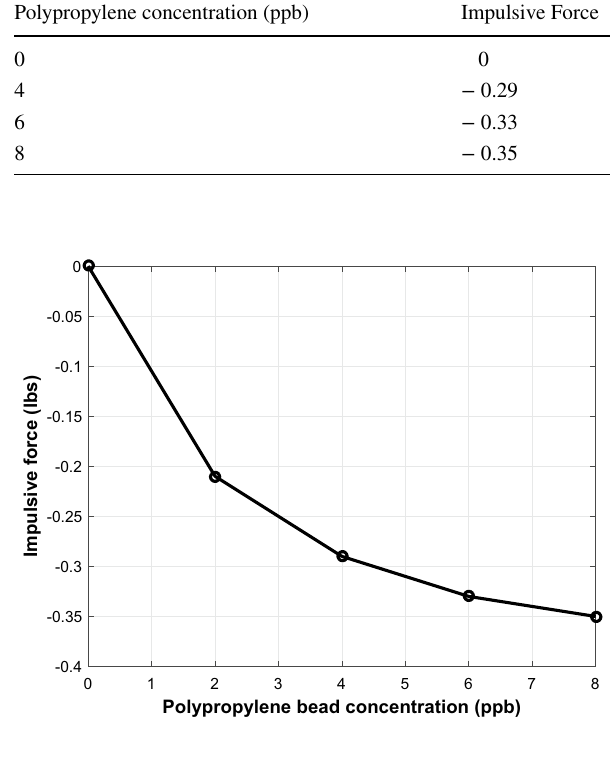
Fig. 10 Impulsive force versus polypropylene beads